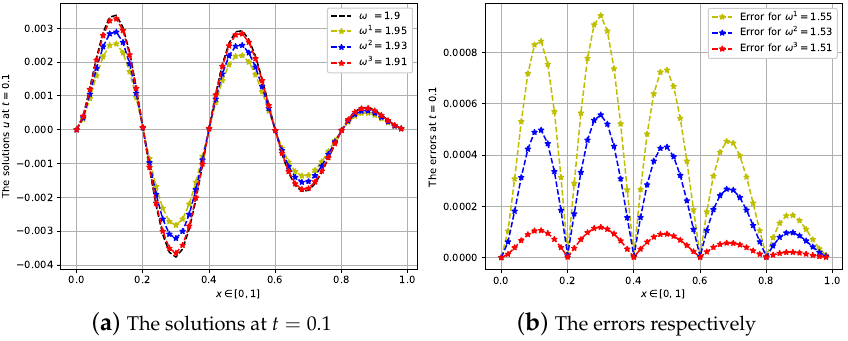
Figure 10. The solution u for ω = 1.9, ω i ∈ { 1.95,1.93,1.91 } at t = 0.1 and the respective